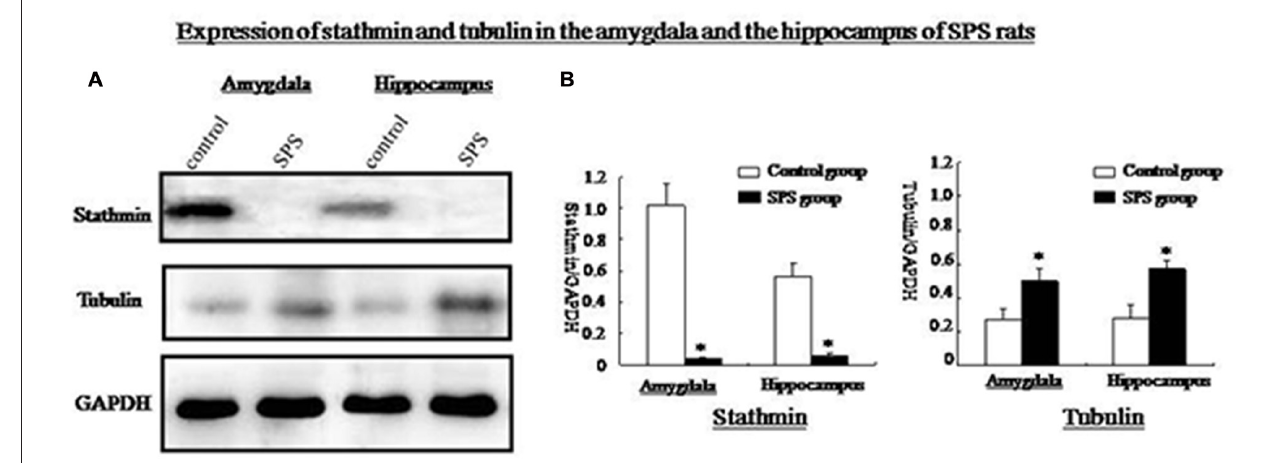
FIGURE 3 | (A) Western blot analysis of stathmin and tubulin in amygdala and hippocampus from control and SPS groups. (B) Quantification of western blots showed that, stathmin was significantly decreased while tubulin was remarkably increased in both brain regions of SPS rats compared with control rats ( ∗ P < 0.05 vs. the control group).